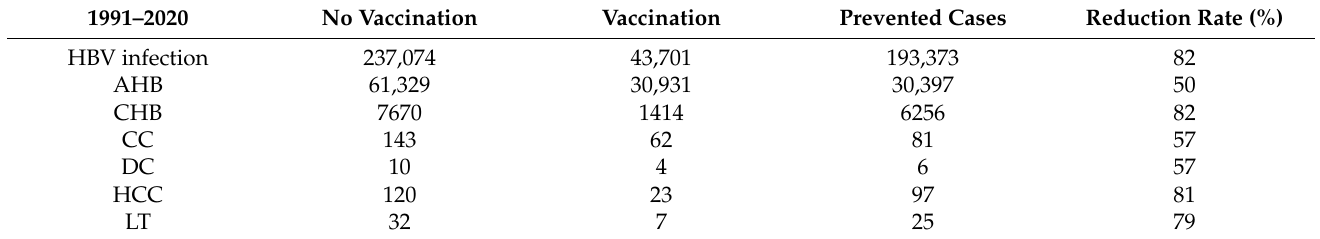
Table 3. Total number of clinical cases related to HBV infection in Italy (AHB: Acute Hepatitis B; CHB: Chronic Hepatitis B; CC: Compensated Cirrhosis; DC: Decompensated Cirrhosis HCC: Hepatocellular carcinoma; LT: Liver